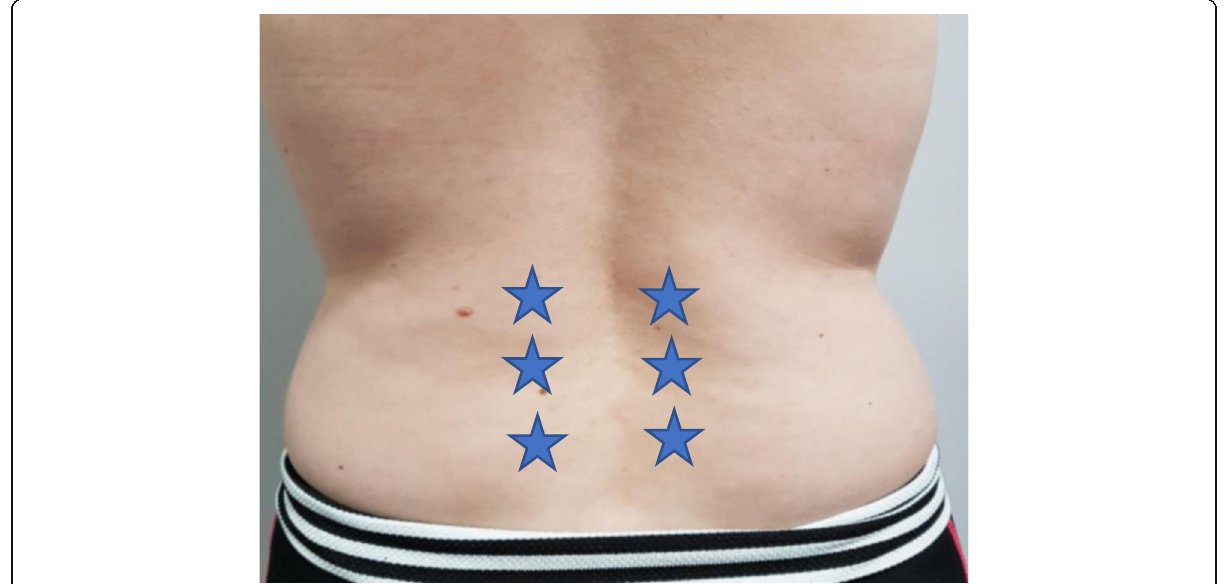
Fig. 1 Location of points for pulsed laser, pulsed ultrasound and continuous ultrasound treatment in the lumbar